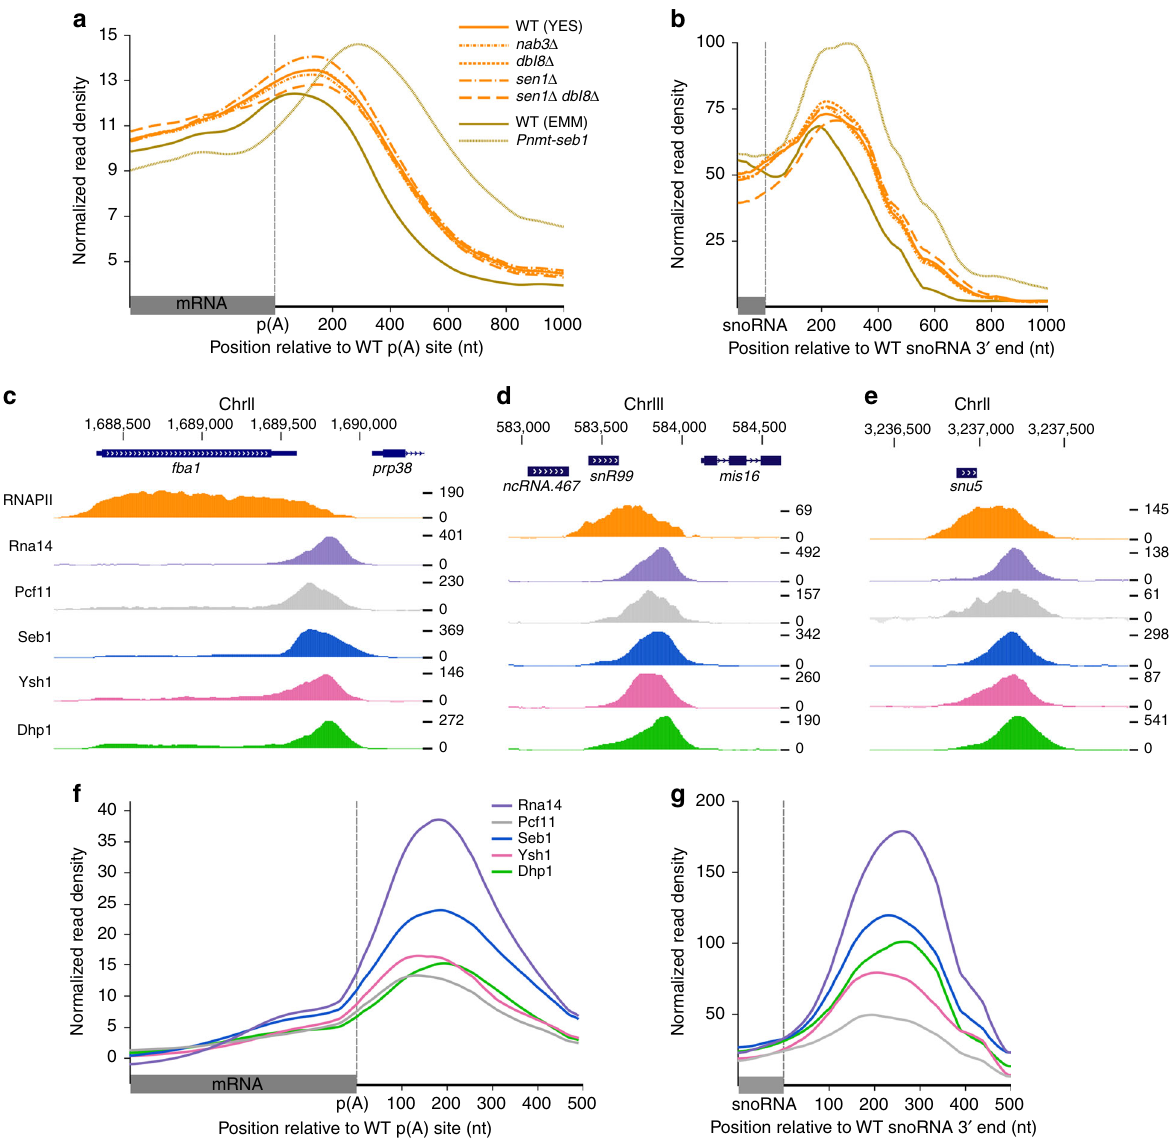
Fig. 1 S. pombe mRNA 3 ′ end processing and transcription termination factors are recruited at the 3 ′ end of independently transcribed snoRNA and snRNA genes. a , b Average ChIP-seq pro fi les of total RNAPII (Rpb1) relative to mRNA poly(A) site ( a n = 4755) and to annotated 3 ′ end of independently transcribed monocistronic snoRNAs ( b n = 31) in WT (solid line, orange) and NNS mutant strains (dotted lines, orange) grown in rich medium (YES). Average ChIP-seq pro fi les of total RNAPII (Rpb1) in WT and Seb1-de fi cient cells ( Pnmt-seb1 ) grown for 15 h in thiamine-supplemented minimal medium (EMM) are also shown (gold). Gene coordinates are available in Supplementary Data 1 – 2. c – e Normalized ChIP-seq signal of RNAPII (Rpb1) and the indicated mRNA 3 ′ end processing factors across the fba1 mRNA ( c ), the snR99 snoRNA ( d ), and the snu5 snRNA ( e ) genes. f , g Average ChIP-seq pro fi le of the indicated mRNA 3 ′ end processing factors over the same groups of mRNA ( f ) and snoRNA ( g ) genes as a ,